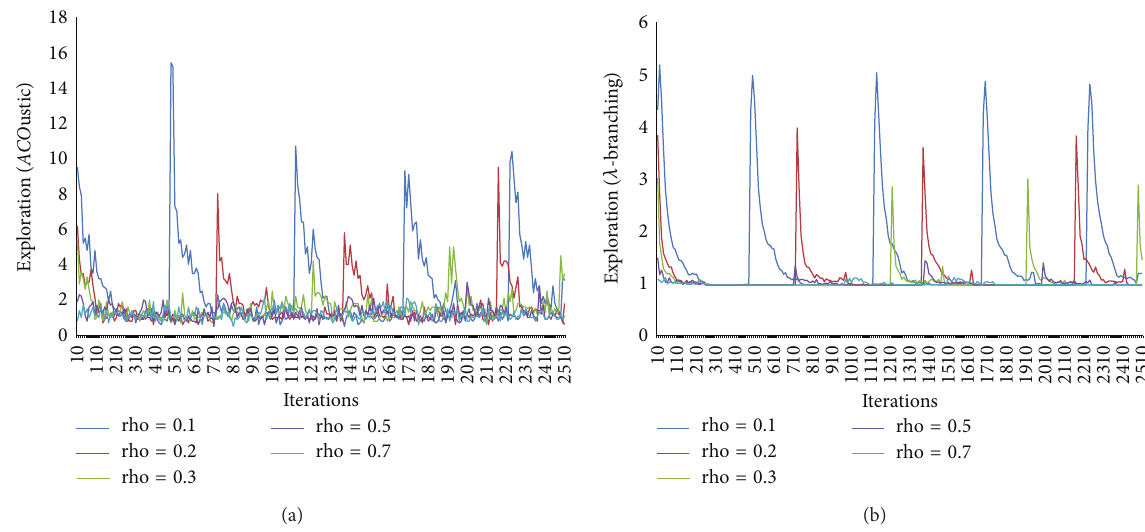
Figure 12: The effect of preheuristic (beta) measured by ACO ustic (a) and measured by 𝜆 -branching